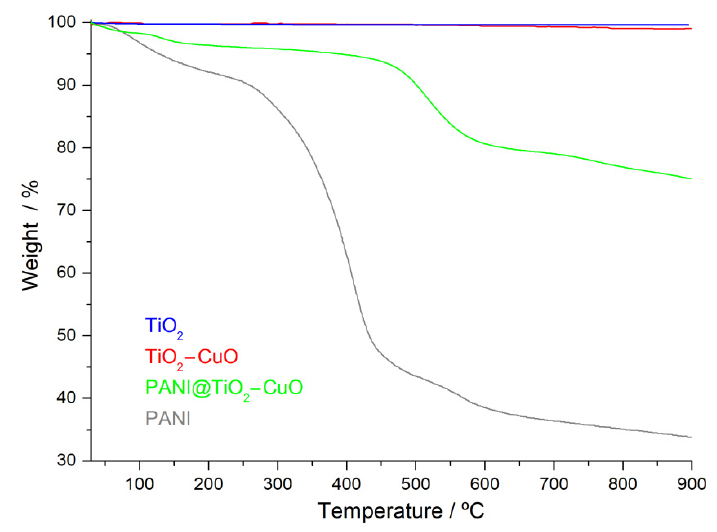
Figure 7. TGA curves of samples.